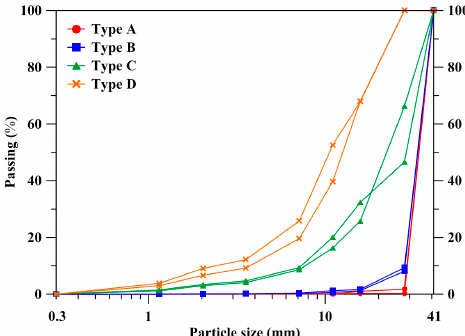
Figure 7. Size distribution of particles in specimens after the SHPB test. Table 2. Description for each failure type.